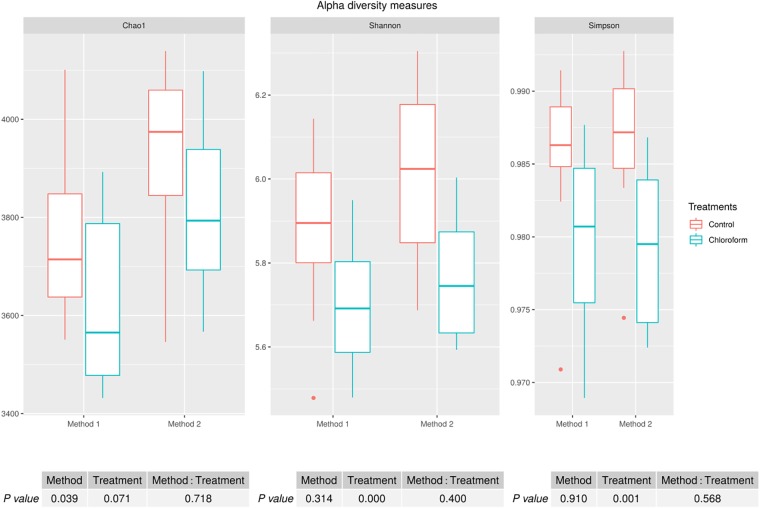
Alpha diversity measures for rumen microbiomes for control and chloroform treatments for processing Methods 1 and 2. Boxplots indicate variance within the sampled animals with the box boundaries showing the first and third quartiles, the median value indicated as a horizontal line and the whiskers extend to 1.5 times the interquartile range.